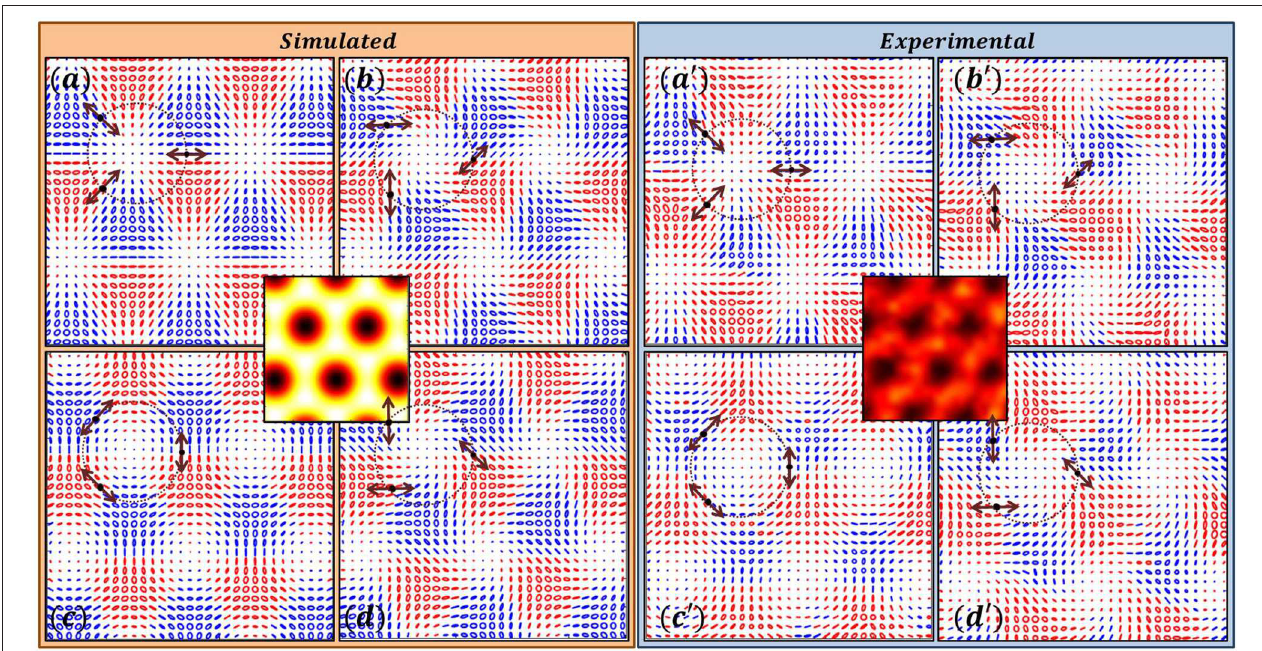
FIGURE 3 | Three-Beam Interference of plane polarized plane waves producing lattice of stars. (a–d) Simulation; (a ′ –d ′ ) Experimental results. This and in the following figures the intensity distribution shown at the center is same for different SOP distributions shown around it. The SOPs of the interfering plane waves are shown on a ring in k-space, with the positions of the dots indicating the transverse components of the propagation vectors. The SOPs of the plane waves in all the interference patterns are chosen from the polarization distributions of V-point singularities having same Poincaré-Hopf index, in this case η = + 1.